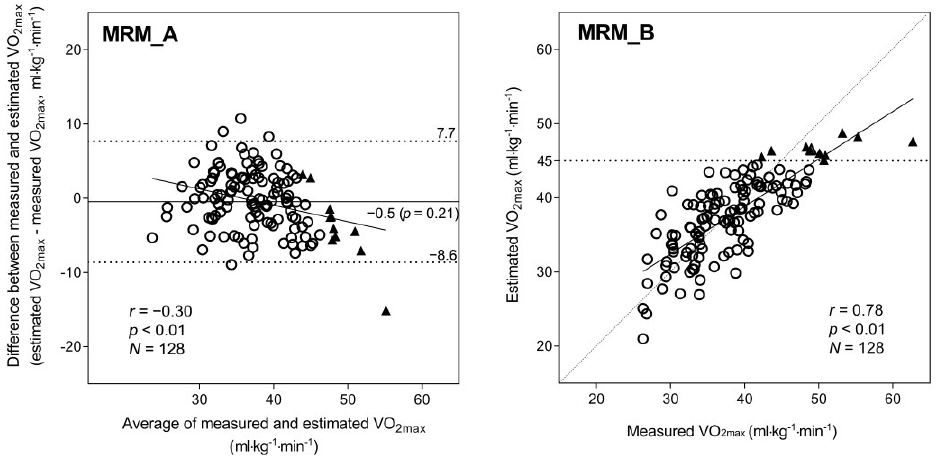
Figure 1. Bland–Altman plot ( A ) and correlation chart ( B ) with mVO 2max and eVO 2max using the